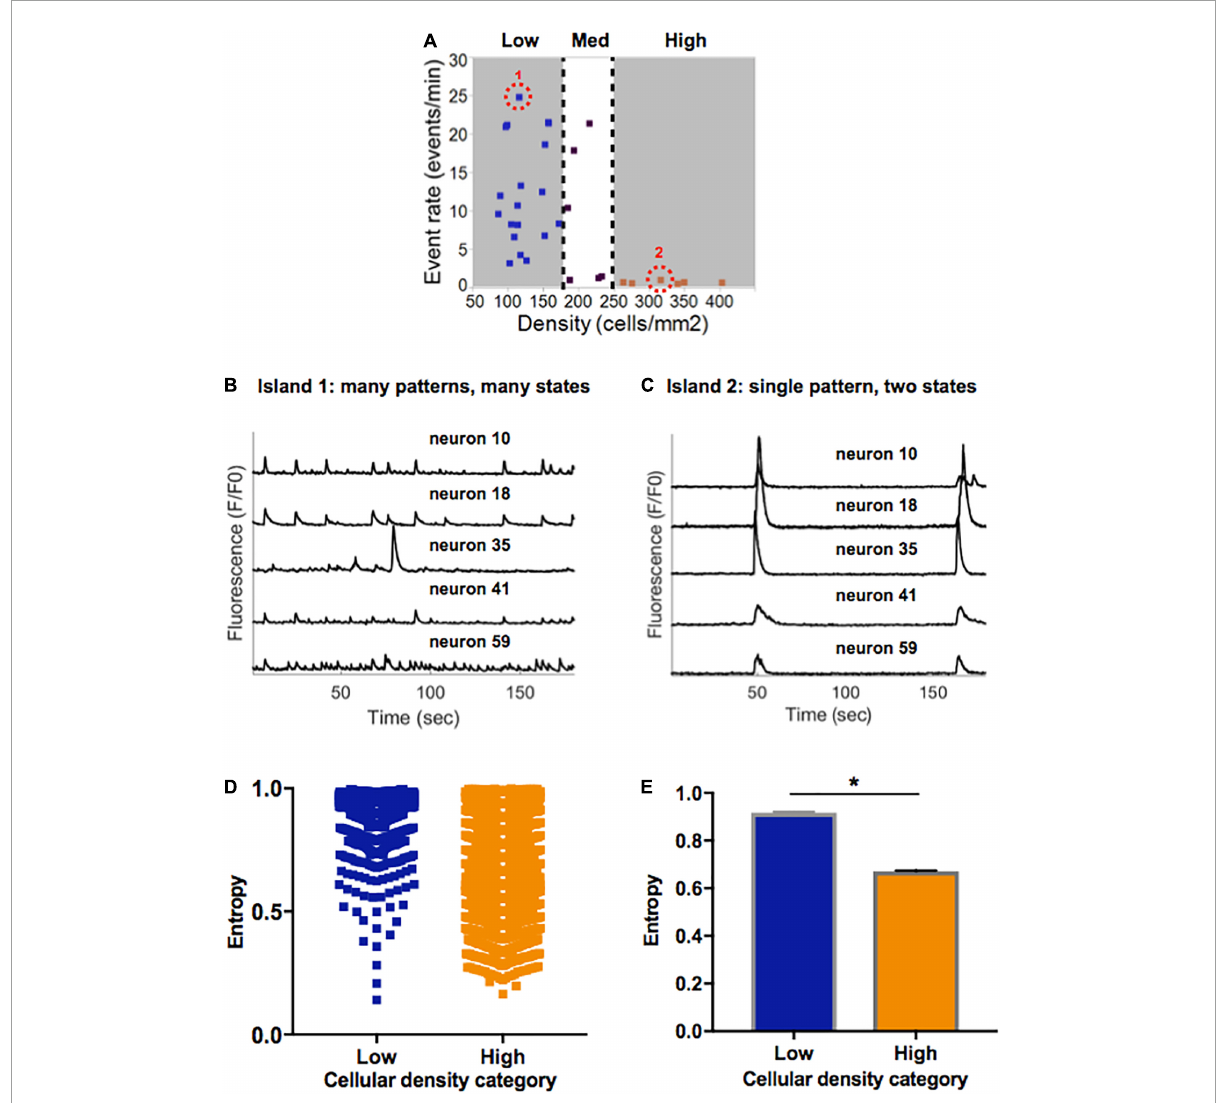
FIGURE5 Information entropy in islands of varying densities. (A) Selected representative islands form the low- and high-density category. (B) Five example traces of individual neurons within Island 1 (low density) display a rich pattern of activity. (C) Five example traces of individual neurons within Island 2 (high density) only achieve one pattern of activity which is highly synchronized. (D) Distribution of single cell entropy values at baseline across neurons in low ( n = 1471) and high ( n = 3024) density circuits. Each point represents an individual neuron within an island of the designated density. (E) Aggregate average entropy levels are significantly higher in low compared to high cellular density islands (0.92 ± 0.002 vs. 0.67 ± 0.003, p < 0.0001). Significance level for statistical testing was set at 0.01 (* p < 0.01) in Mann–Whitney